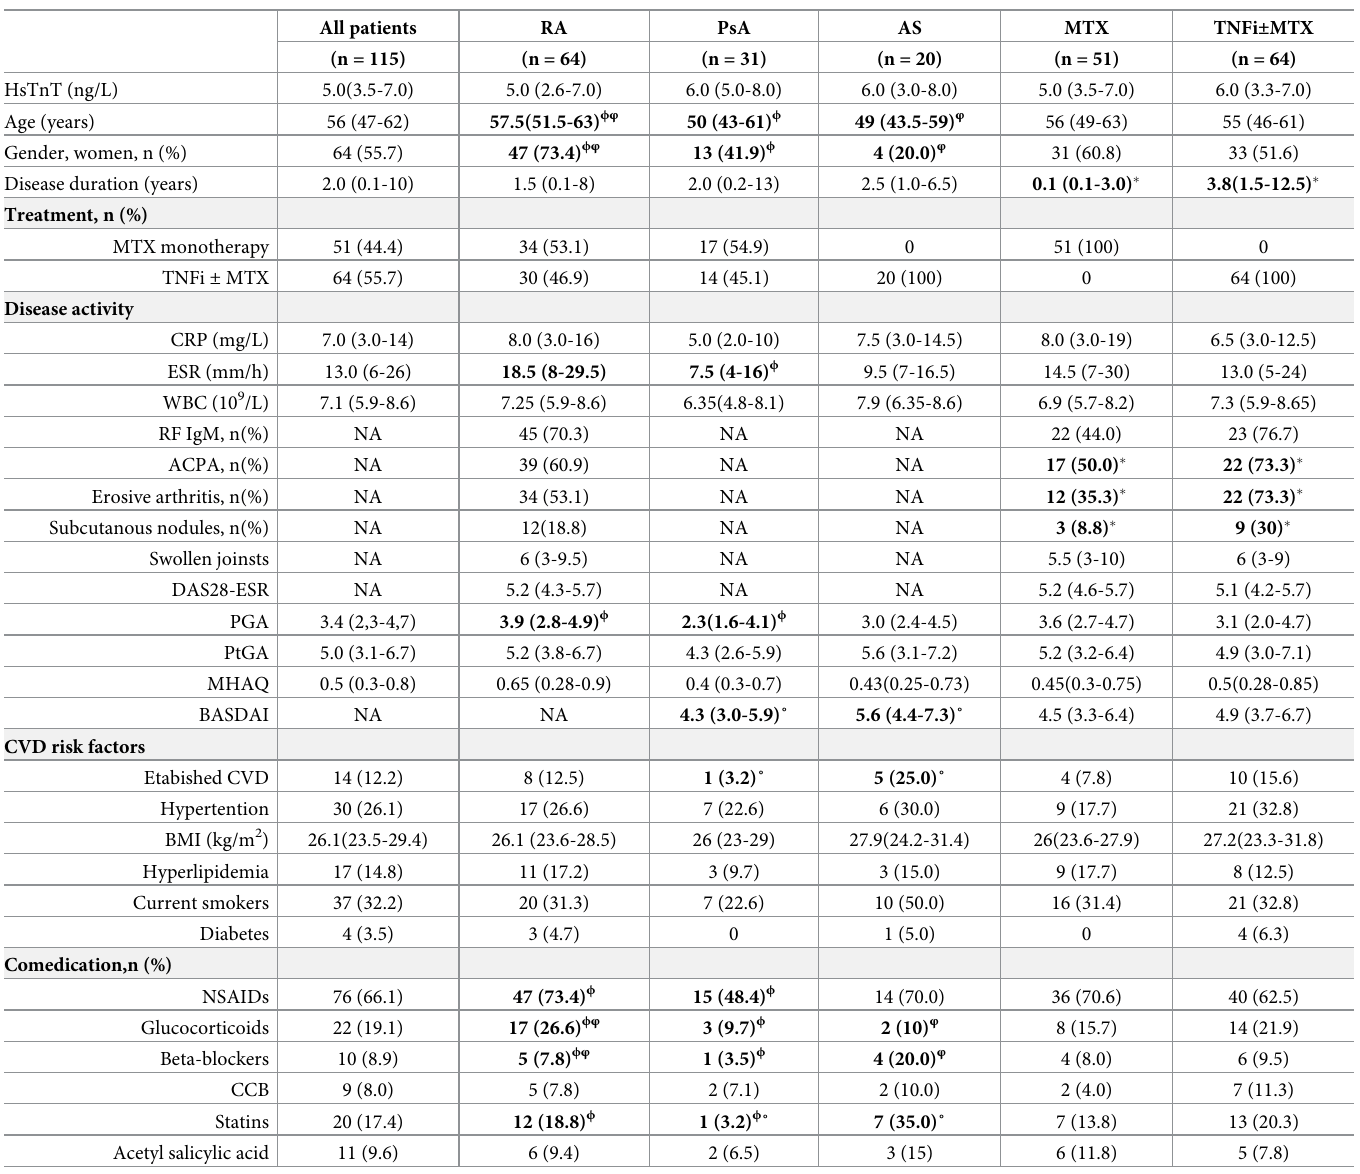
Table 1. Baseline